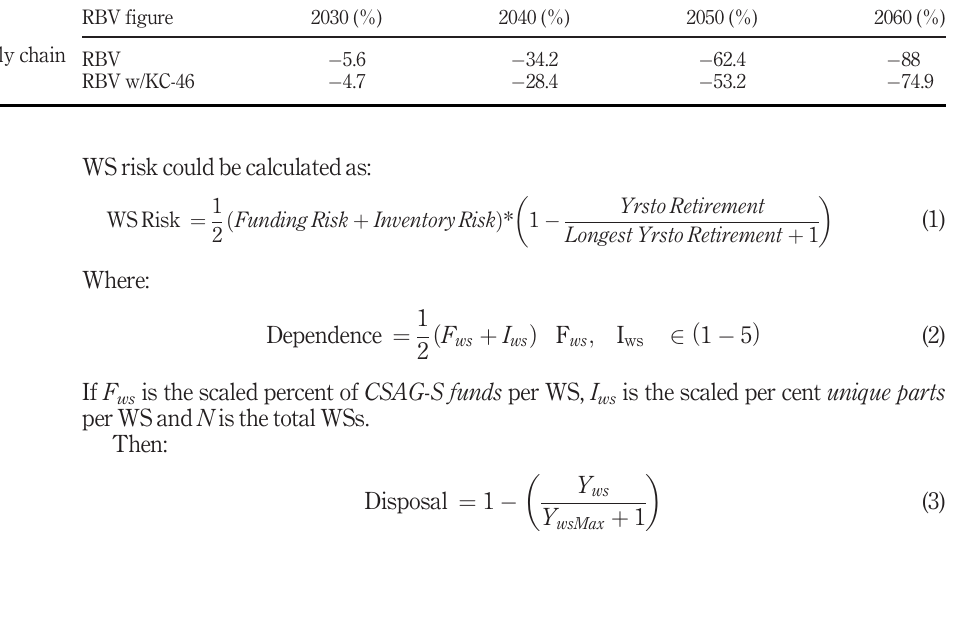
Figure 9. RBV by WS over retirement with KC- 46 estimates